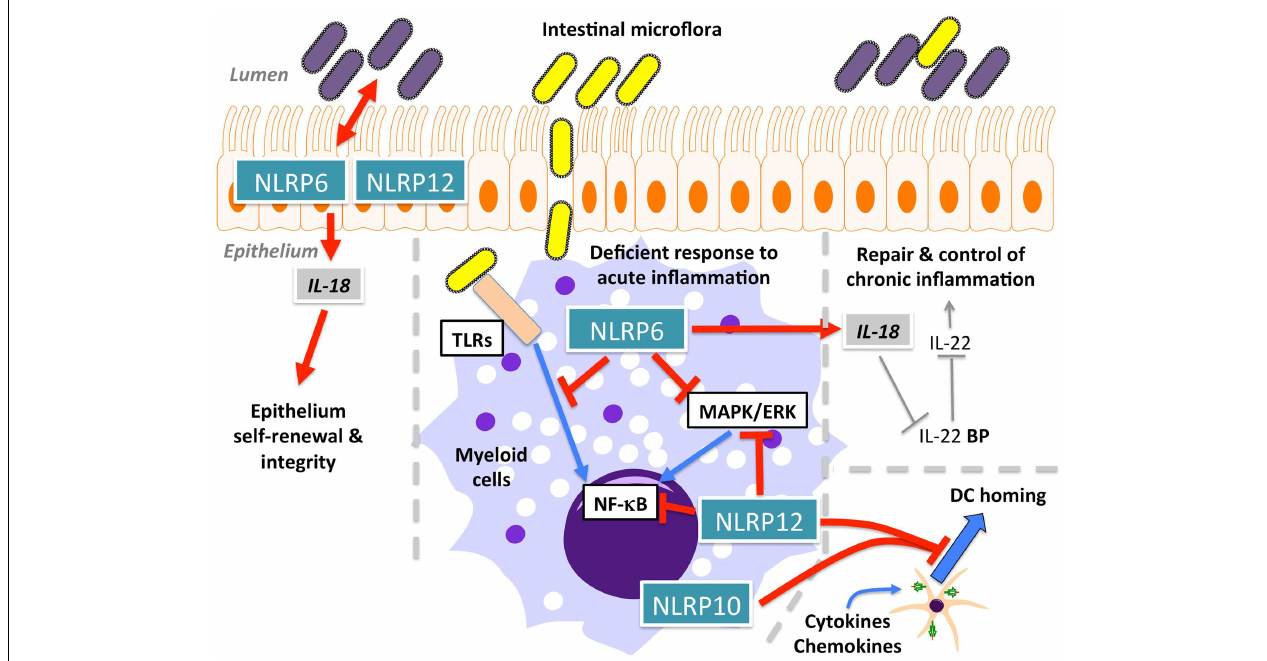
FIGURE 5 | Function of NLRP6, NLRP10, and NLRP12 in intestinal homeostasis and dendritic cell (DC) homing .